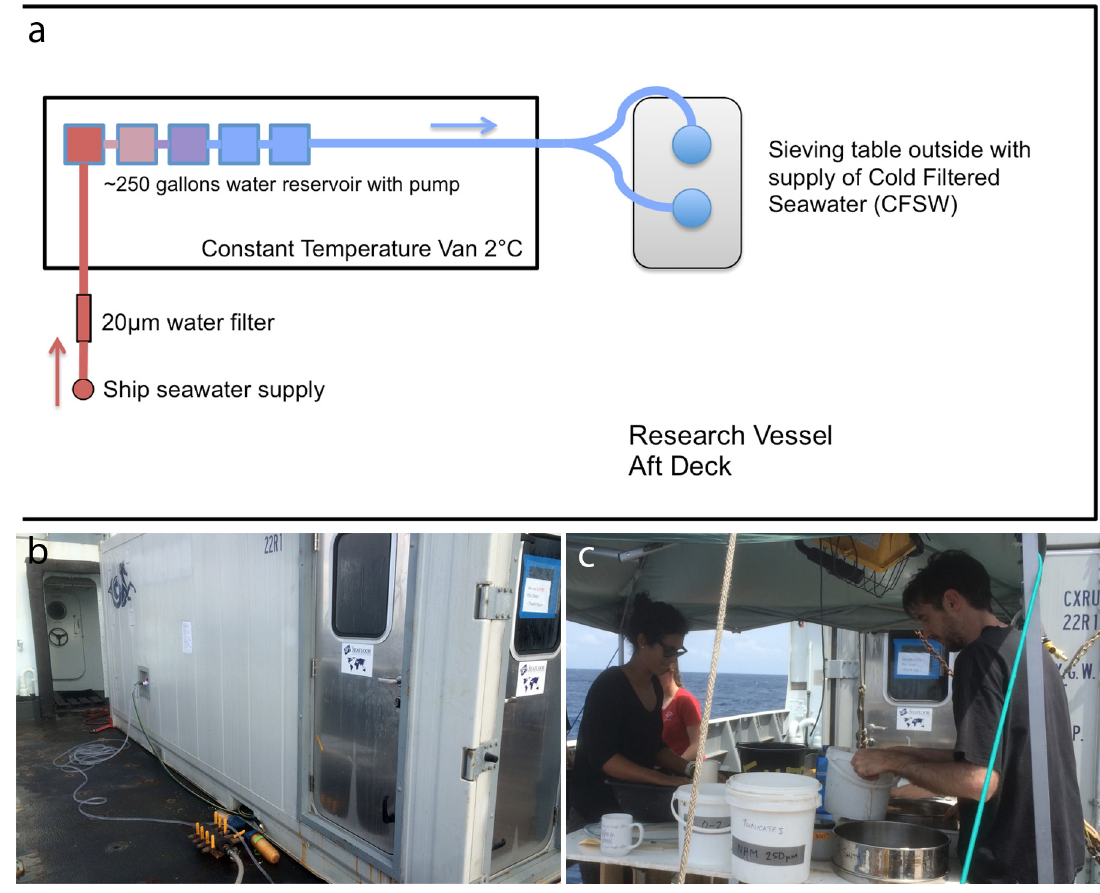
Figure 12. Typical cold filtered seawater (CFSW) setup on ABYSSLINE